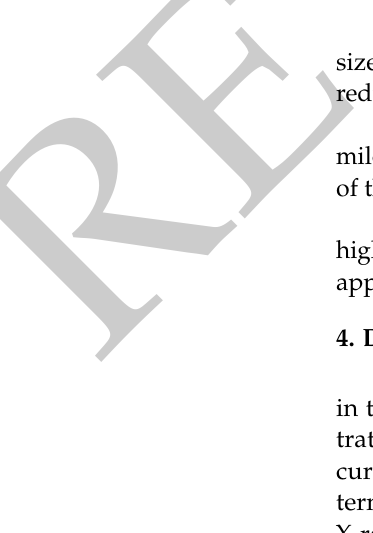
Figure 6. X-ray changes in brain structure in different treated groups with D-galactose, chitosan nanoparticles, Resveratrol, Quercetin: ( A ) Control group: Appearance of normal structure of the brain; ( B ) D-galactose group: Appearance of the diminished Corpus callosum with reduced size as a spot with very reduced horns; ( C ) D-galactose + Chitosan (Low dose) + Quercetin Resveratrol group: Appearance of mild ameliorative effect on internal horns, both anterior and posterior with mild restoration of thalamus and normal sized Corpus callosum; ( D ) D-galactose + Chitosan (High dose) + Quercetin Resveratrol group: Appearance of highly ameliorative effect on brain structure x-ray with restoration of both horns the normal appearance with a mid-sized